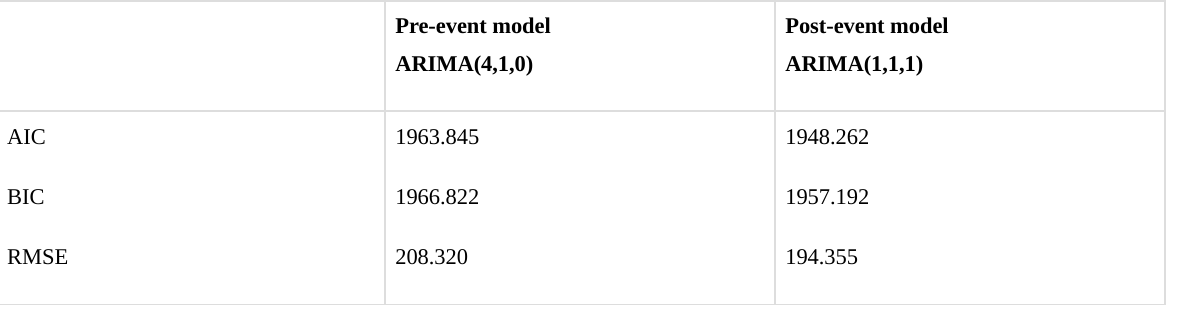
Note. ARIMA = autoregressive integrated moving